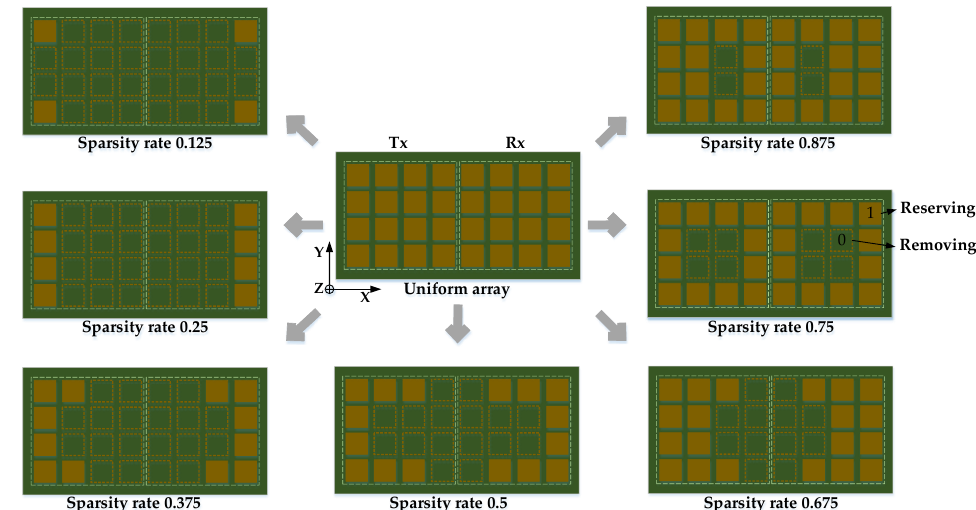
Figure 5. The uniform planar array and array configuration at different sparsity rates. The far-field transmit and receive patterns of the SIC-BF-spare at sparsity rate of 0.75 are compared to the SIC’s and SIC - BF’s as shown in Figure 6. At the beam scan angle of